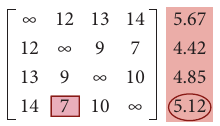
Figure 5: The 4 × 4 distance matrix.